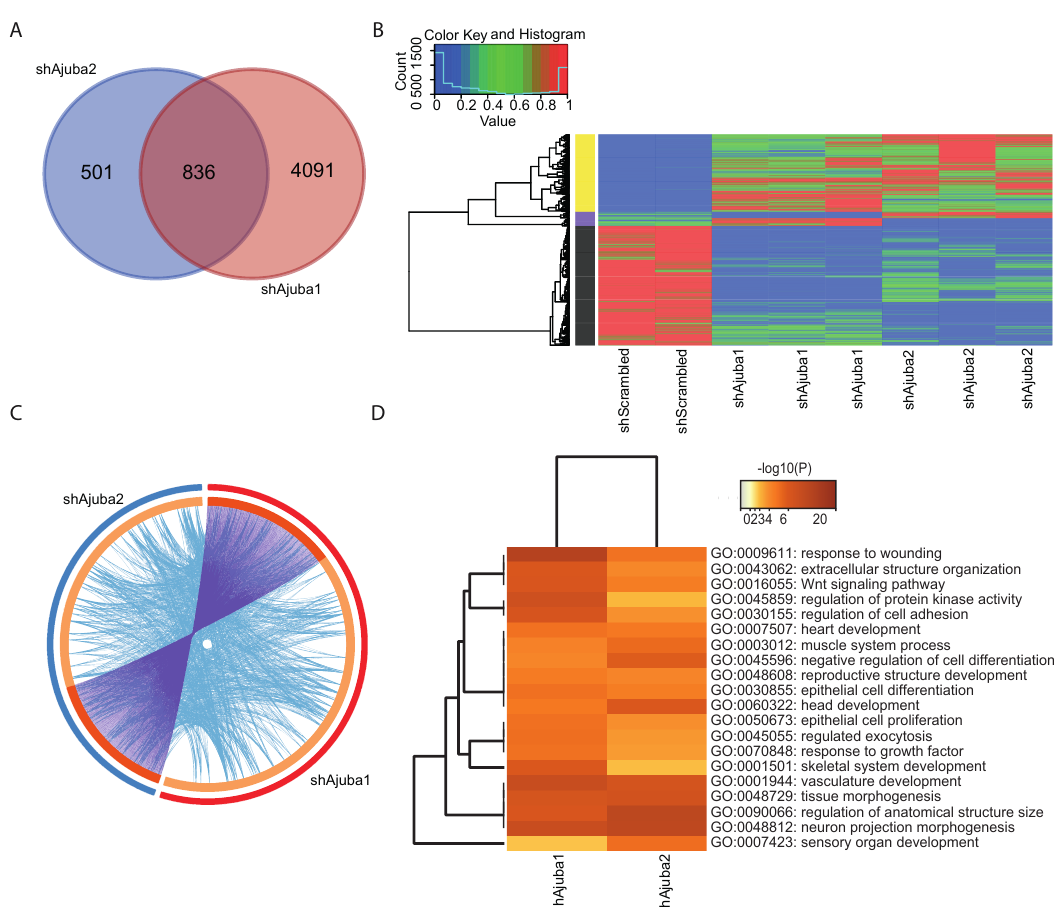
Figure 4. Common DEG of the two Ajuba KD are involved cell adhesion, cell di ff erentiation and proliferation. ( A ) Venn diagram of commonly expressed genes comparing all DEG of shAjuba1 and its control and shAjuba2 with its control. ( B ) Heat map of all 836 commonly altered DEG from shAjuba1 and shAjuba2. ( C ) Circos plot calculated using multiple gene list on Metascape shows how the genes from shAjuba1 and shAjuba2 overlap and in which pathways they are involved. The blue line on the outside corresponds to the shAjuba2 gene list and the red line on the outside to shAjuba1. On the inside, Dark orange color represents the genes that are common in shAjuba1 and shAjuba2, the light orange color represents genes that are uniquely expressed by one condition. The purple lines are linking the exact genes that are common in shAjuba1 and shAjuba2. Blue lines link genes that are di ff erent but have the same gene ontology term. ( D ) Heat map showing the top 20 statistically significant family of pathways, clustered by Metascape, were displayed showing commonly altered pathways from shAjuba1 and shAjuba2 the yellow line showing their p -value and in which gene ontology term they are